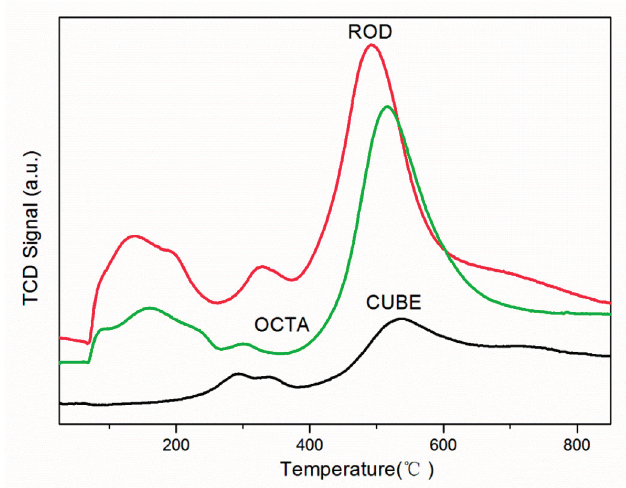
Figure 8. CO-TPR profiles of nano-CeO 2